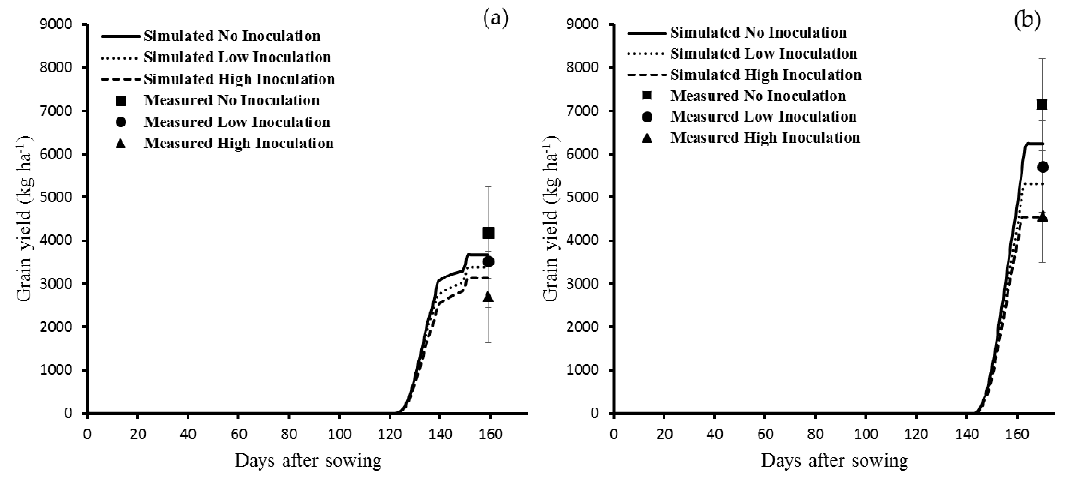
Figure 5. Simulated and measured grain yield values for cultivar K. Chaja year 2010 ( a ) and 2011 ( b ) including different inoculation treatments with STB. The error bars demonstrate the LSD of the yield.